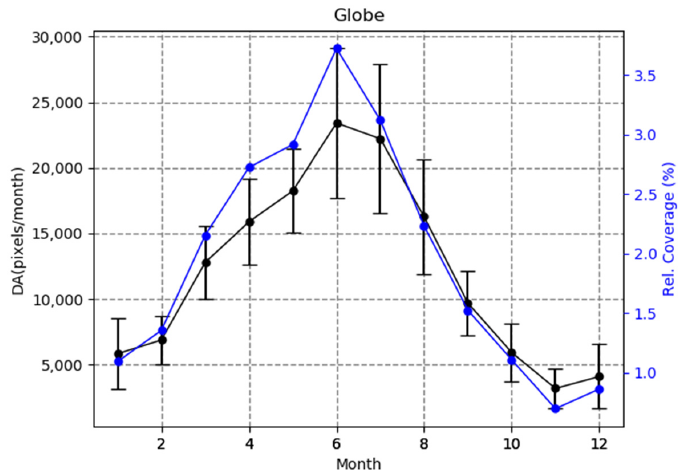
Figure 5. Intra-annual variability of the 2005–2019 averages of the global total absolute number of grid cells (1 ◦ × 1 ◦ ) where dust aerosols (DA) were detected by the satellite algorithm (left axis) and the percentage global coverage by dusty grid cells (right axis). The error bars represent the year-by-year variability by means of computed 2005–2019 standard